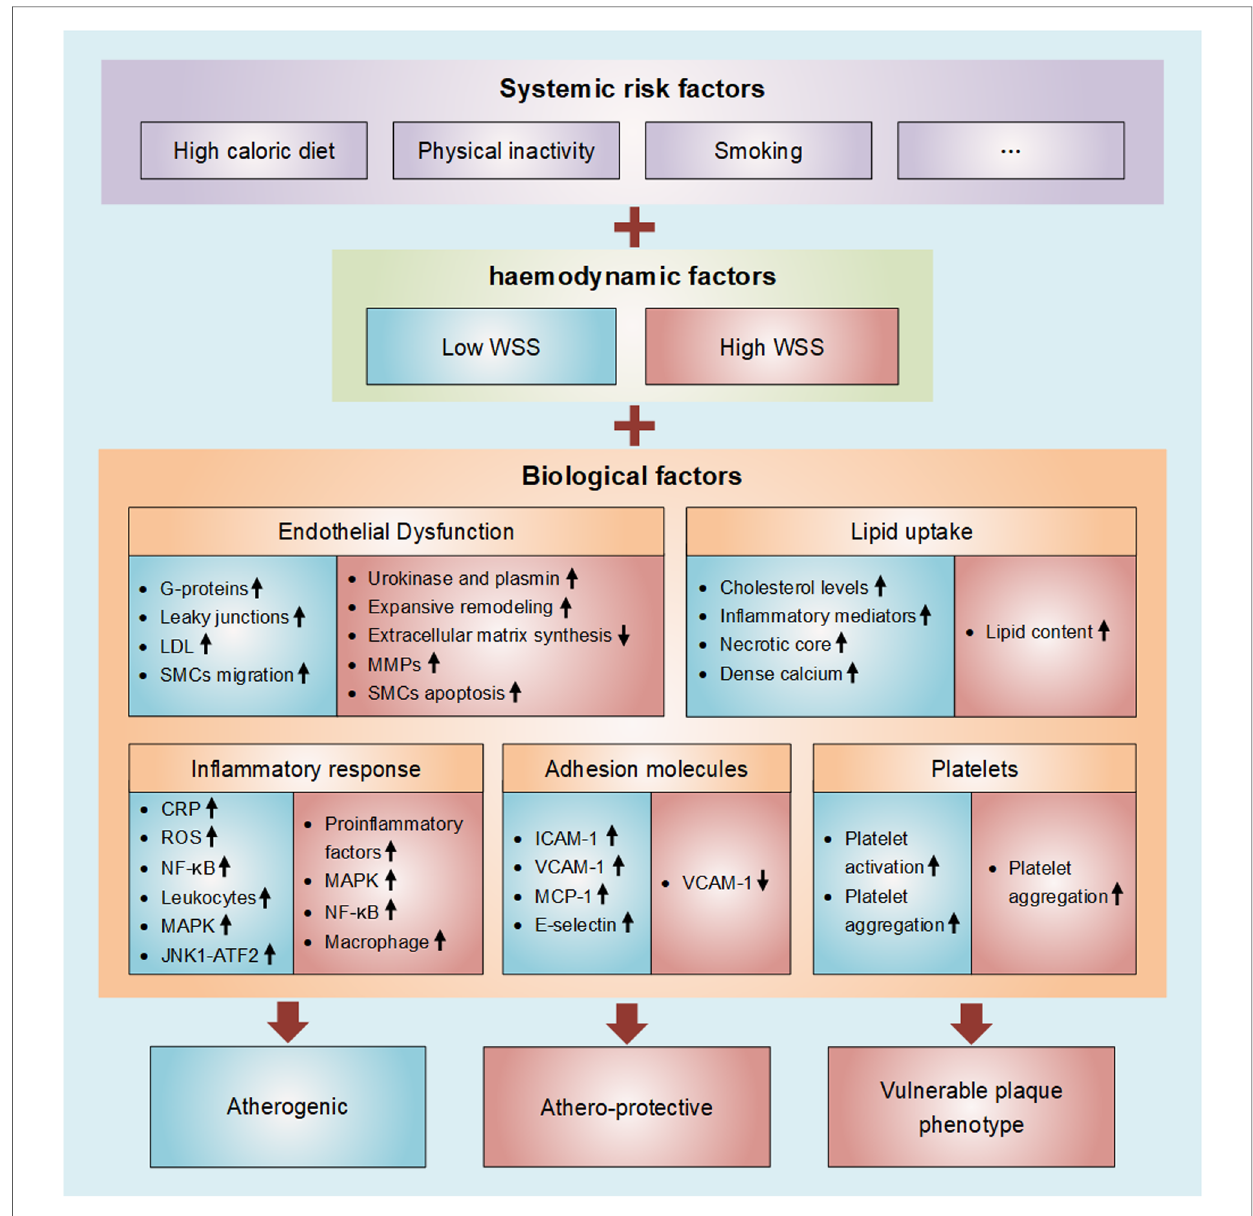
FIGURE 1 Diagram of wall shear stress involved in atherosclerosis. Atherosclerosis is thought of as subject to a triad of, and especially interactions among, systemic risk factors, haemodynamic forces, and the biological response of the wall. Atherosclerosis is characterized by progressive endothelial cell injury, arterial in fl ammation, lipid deposition, platelet activation, and the accumulation of extracellular matrix in the arterial wall. These biological factors are all strongly in fl uenced by WSS (Blue represents low WSS and red represents high